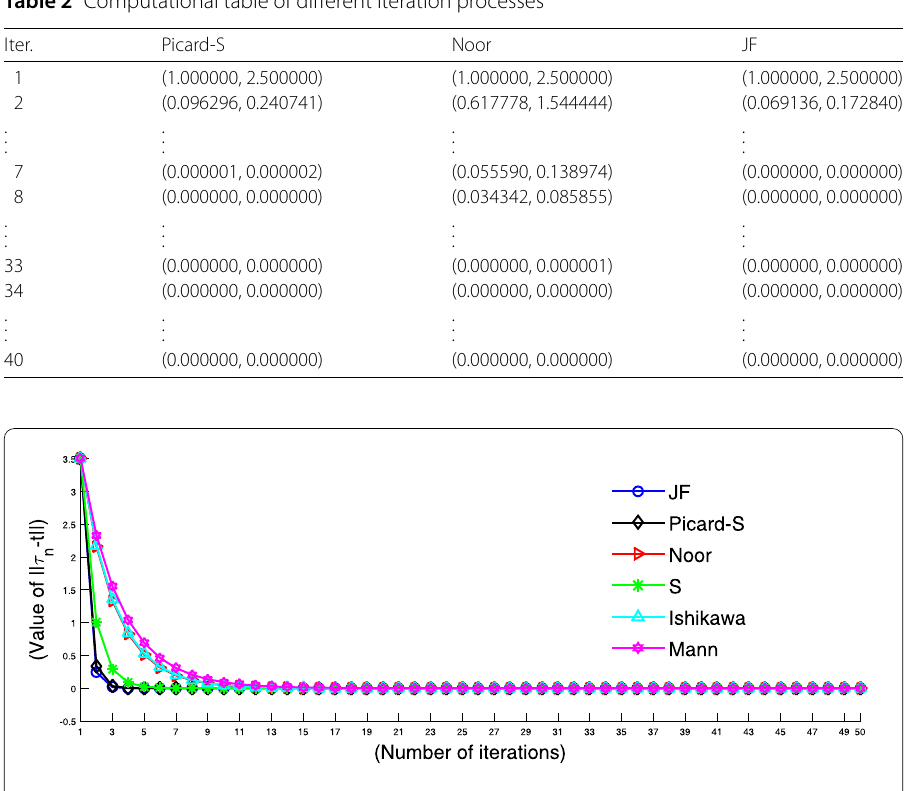
Figure 1 Convergence behavior of the sequences defined by distinct iteration